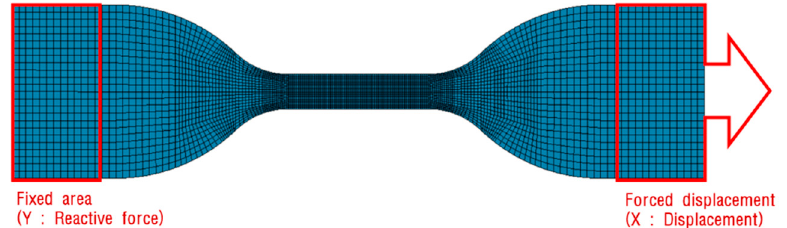
Figure 5. Finite element model for tensile specimen of ethylene propylene diene monomer (EPDM) 60 material.